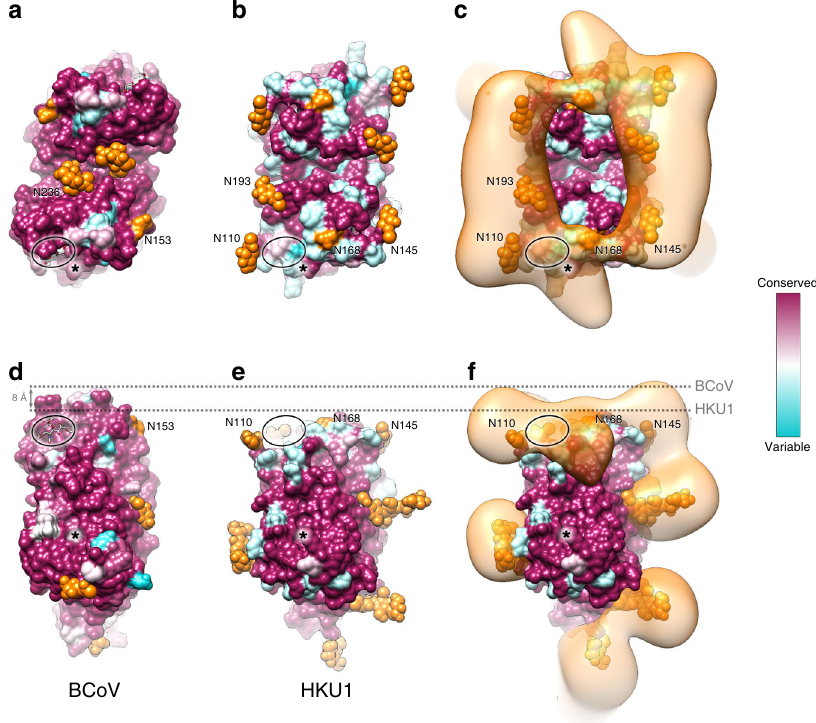
Fig. 5 Visualizing the glycan crown of HKU1 HE lectin domain. a Top down view of the dimeric BCoV HE lectin domain, shown as a surface representation and coloured according to sequence conservation (67 sequences). N -linked glycosylation sites are labelled, coloured orange and, if modelled, shown as spheres. The sialic acid binding site is circled and esterase active site is indicated by an asterisk. b Equivalent view as shown in A for HKU1 HE (40 sequences). c The same view as shown in B overlaid with the HKU1 HE N -linked glycan EM difference density, coloured orange. d Side view of BCoV HE and ( e – f ) HKU1 HE, depicted as in ( a – c ). The most membrane distal region of BCoV and HKU1 HE is indicated by a dashed